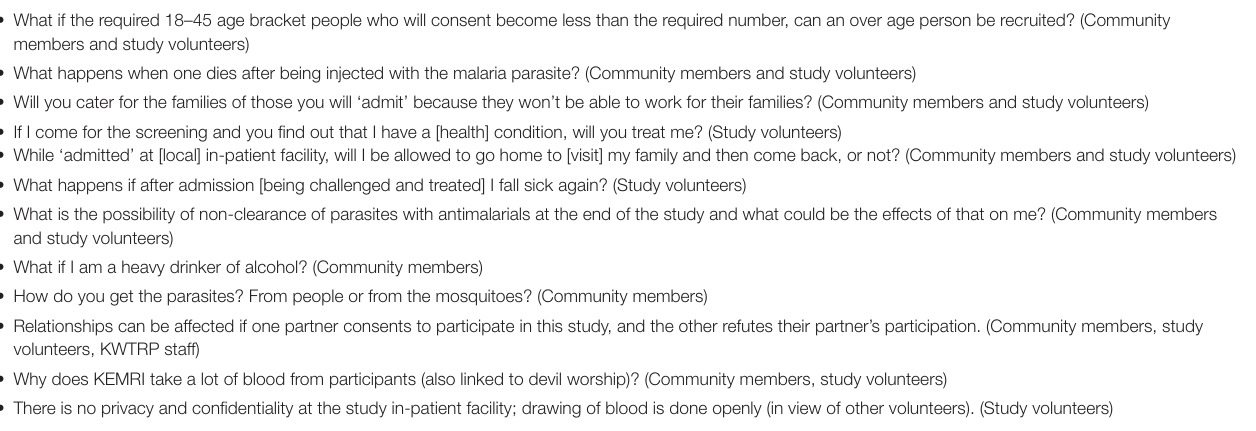
TABLE 3 | Common questions and concerns about CHMI–SIKA raised by community members, study volunteers, stakeholders and KWTRP staff who participated in engagement